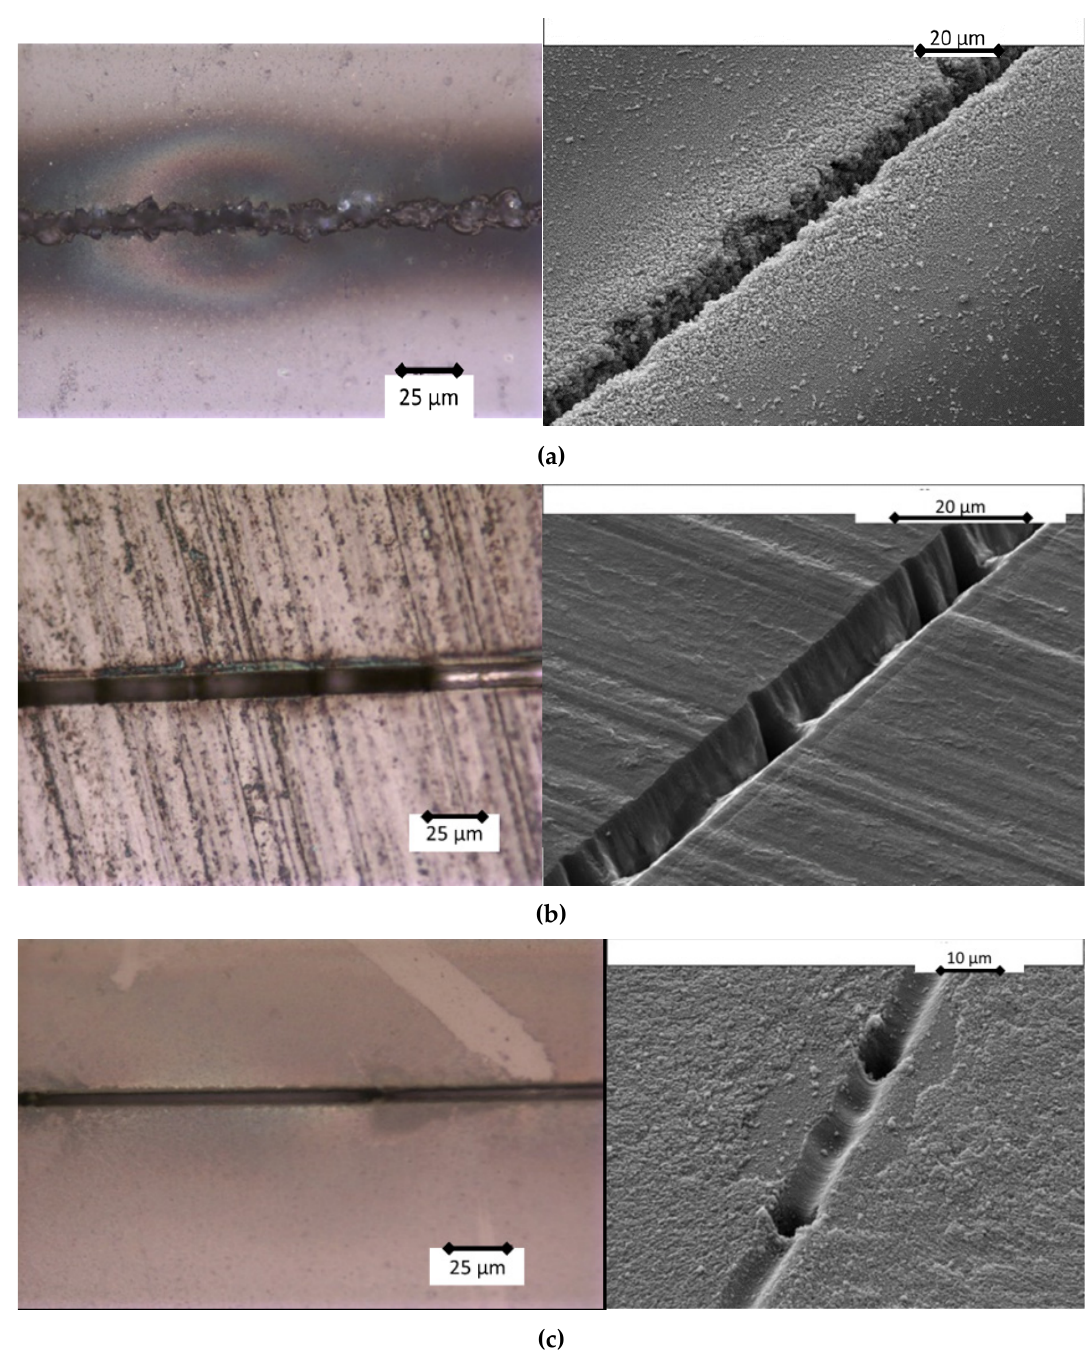
Figure 9. Optical micrographs (left) and SEM micrographs for line surface damage in ( a ) fused silica glass, ( b ) diamond, and ( c ) sapphire at 50 Jcm − 2 , 5 kHz, and 100 mms − 1 .